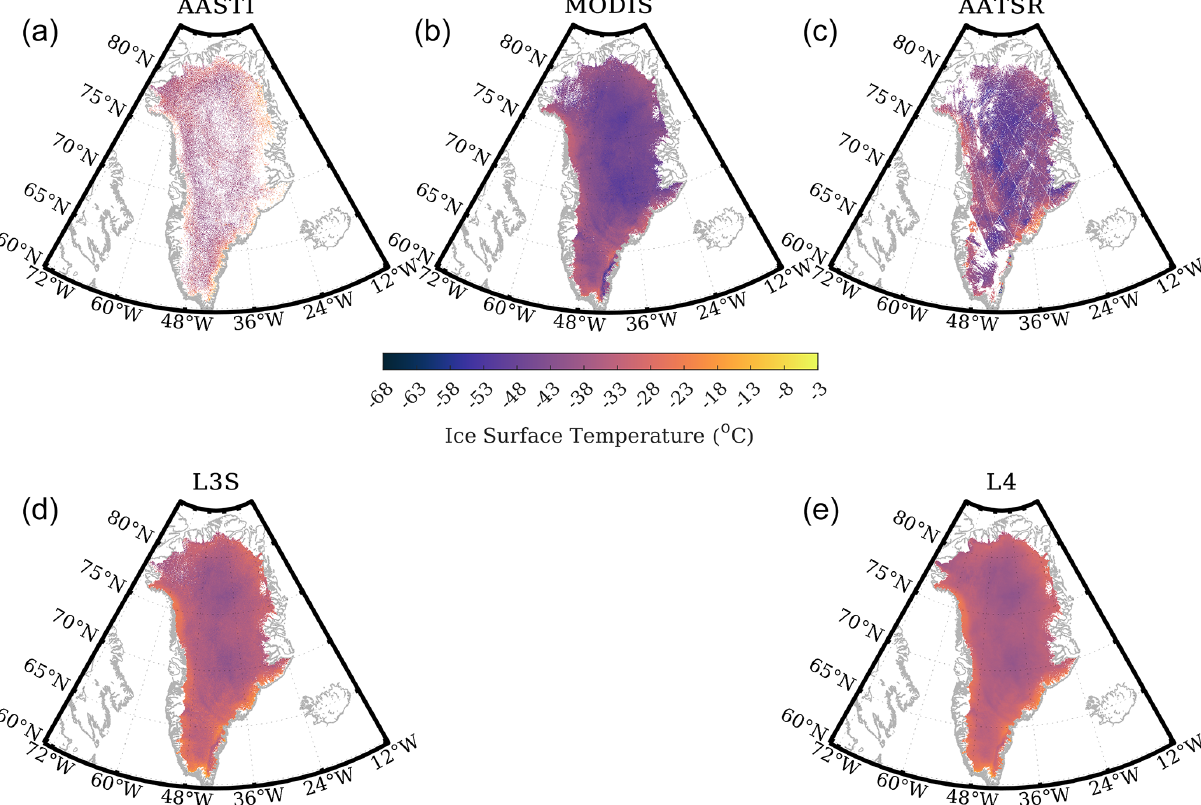
Figure 2. Examples of aggregated IST observations from 9 January 2012 over the Greenland Ice Sheet. Top row: Level 3 AASTI (a) , Level 3 MODIS on Aqua and Terra (b) , Level 3 AATSR (c) . Bottom row: Level 3S (d) , Level 4 optimally interpolated IST (e)